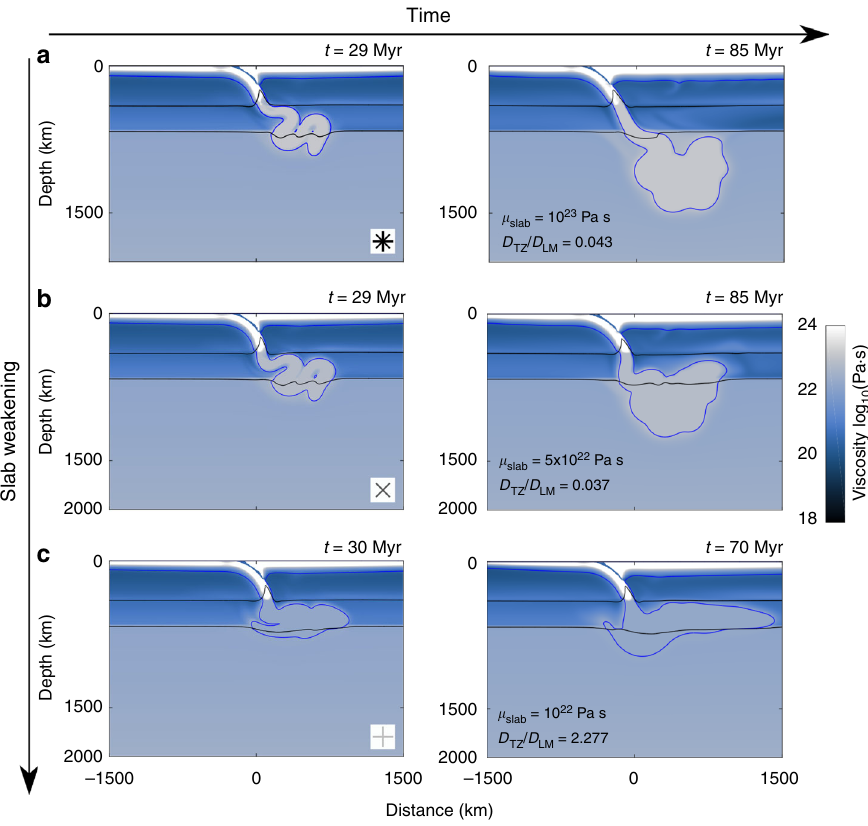
Fig. 5 Weaker slab interaction with the upper – lower mantle boundary. Slab evolution of simulations 20a,b,c in which the maximum viscosity cut-off below 400 km depth is reduced to: a 10 23 , b 5 × 10 22 and c 10 22 Pa s. For the three cases the value of D TZ / D LM is indicated, highlighting how very weak transition- zone slabs tend to